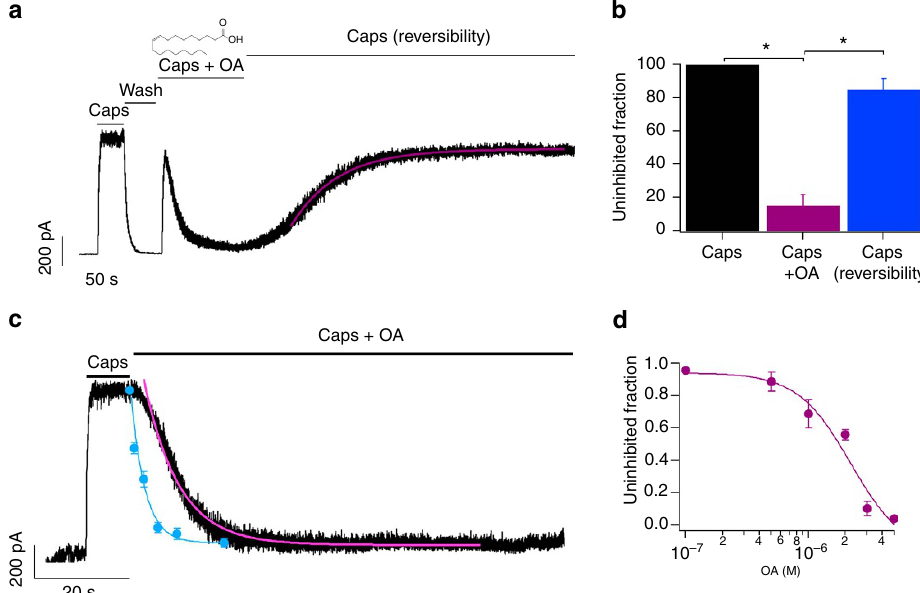
Figure 1 | Heterologously expressed rTRPV1 channels respond to oleic acid. ( a ) Representative trace ( n ¼ 6) of currents evoked at þ 40mV for 350ms from a holding potential of 0mV. Inside-out patches were first exposed to recording solution, then to 4 m M capsaicin (Caps), washed with recording solution (wash), then exposed to 5 m M OA þ Caps until inhibition was achieved. Capsaicin was then reapplied to measure recovery from inhibition (Caps (reversibility)). Data for recovery from inhibition were fit to a single exponential ( t ¼ 38.8 ± 6.5s). ( b ) Average data for experiment in a . Data were normalized to the initial value with capsaicin (black bar). *Denotes P o 0.001 between groups as compared by the brackets. After Caps þ OA (magenta) and after Caps ((reversibility), blue), 15 ± 2.6% and 85 ± 6.3% of the currents remained, respectively ( n ¼ 6). ( c ) Time course of inhibition by 5 m M OA ( n ¼ 5) for the open (black) and closed states (blue). Data were obtained at 60 and (cid:2) 60mV and fit to a single exponential ( t ¼ 2.9s and t ¼ 7.7 ± 0.64s for the closed and open states; blue and pink lines, respectively). ( d ) Dose–response for inhibition of currents activated by 4 m M Caps by OA for 5min (120mV). Smooth curve is a fit with the Hill equation ( K D ¼ 2.2 m M and Hill coefficient ( n ) ¼ 2). Due to seal instability, a single OA concentration in the absence of capsaicin was tested per membrane-patch and the remaining capsaicin-activated current was normalized to the current obtained with capsaicin initially ( n ¼ 5 for each concentration